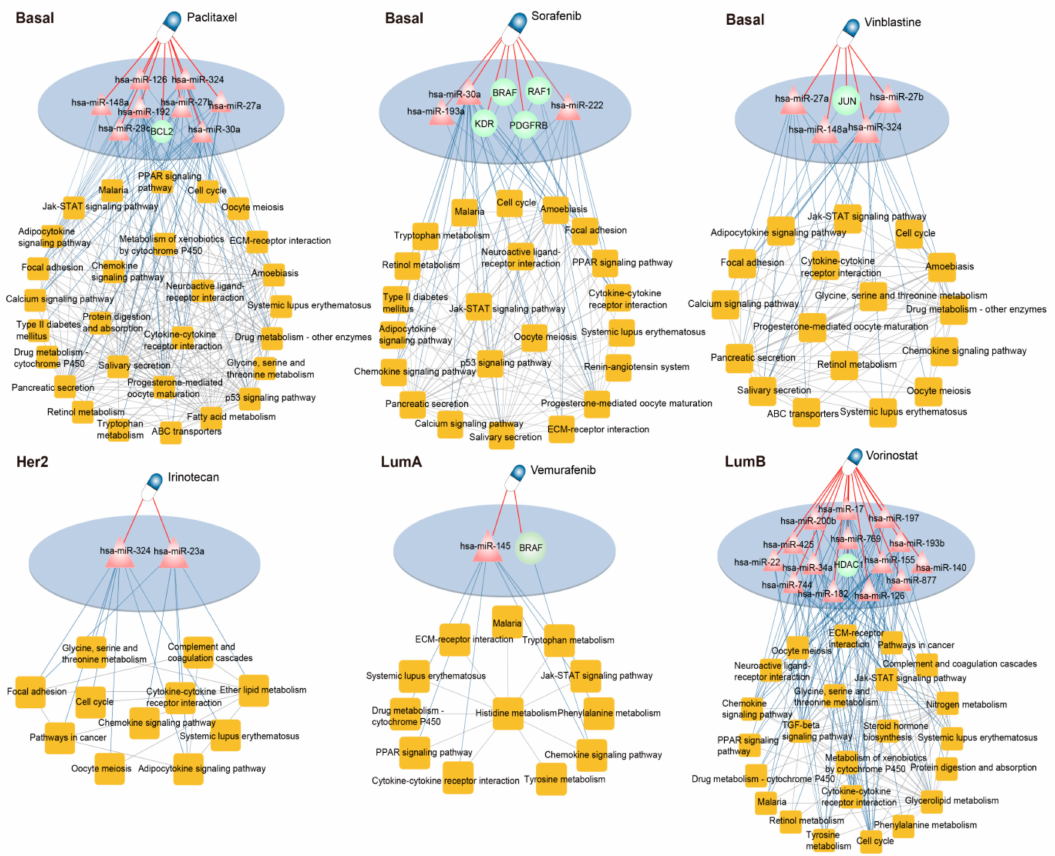
Figure 6. The mechanism of optimal therapeutic drugs in each subtype of breast cancer. Sorafenib, Paclitaxel, and Vincristine were applicable for the basal-like subtype treatment, Irinotecan was optimum for the her2-enriched subtype treatment, Vemurafenib was suitable for the luminal A subtype treatment, and Vorinostat was applied to the luminal B subtype